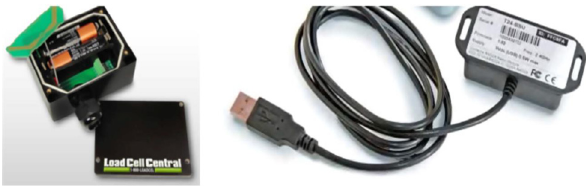
Figure 3: Sensor network that operates wirelessly.